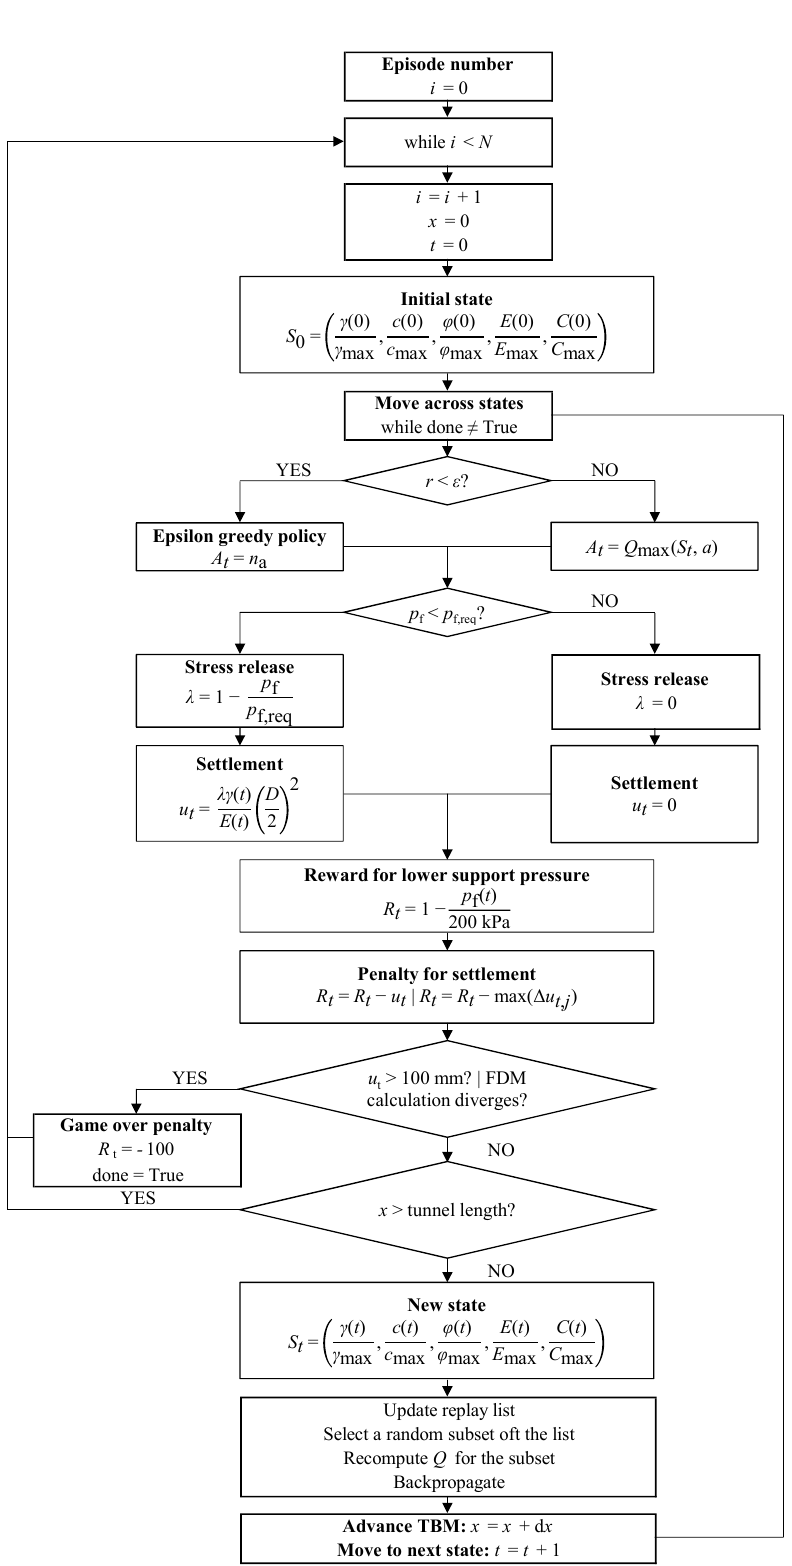
Figure 4. Workflow of the reinforcement learning